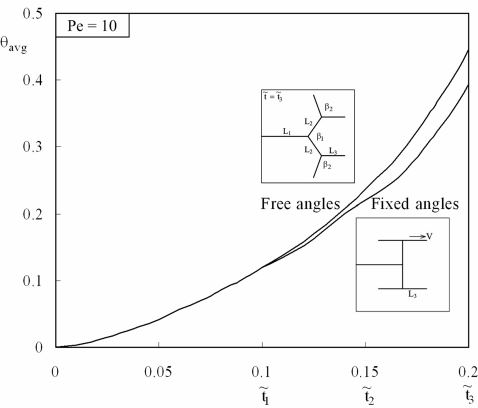
Figure 4: The S curve of tree invasion with free angles is steeper (faster) than the S curve of tree invasion with fixed branching an-